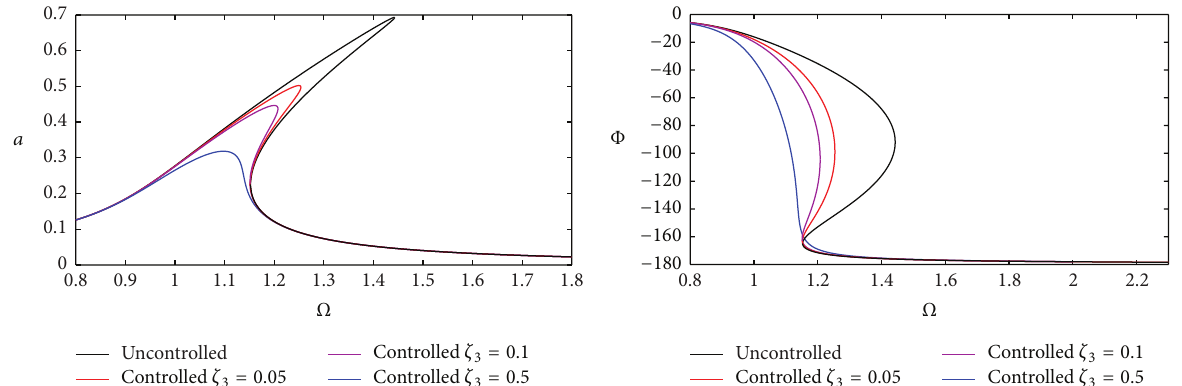
Figure 3: Amplitude-frequency and phase-frequency relationships of the primary resonance for the controlled system under different ̂𝜆 = 0.4 feedback gain 𝜁 3 without time delay ( 𝜁 1 = 0.025 , 𝑓 1 = 0.05 , 𝑘 = 1 , and